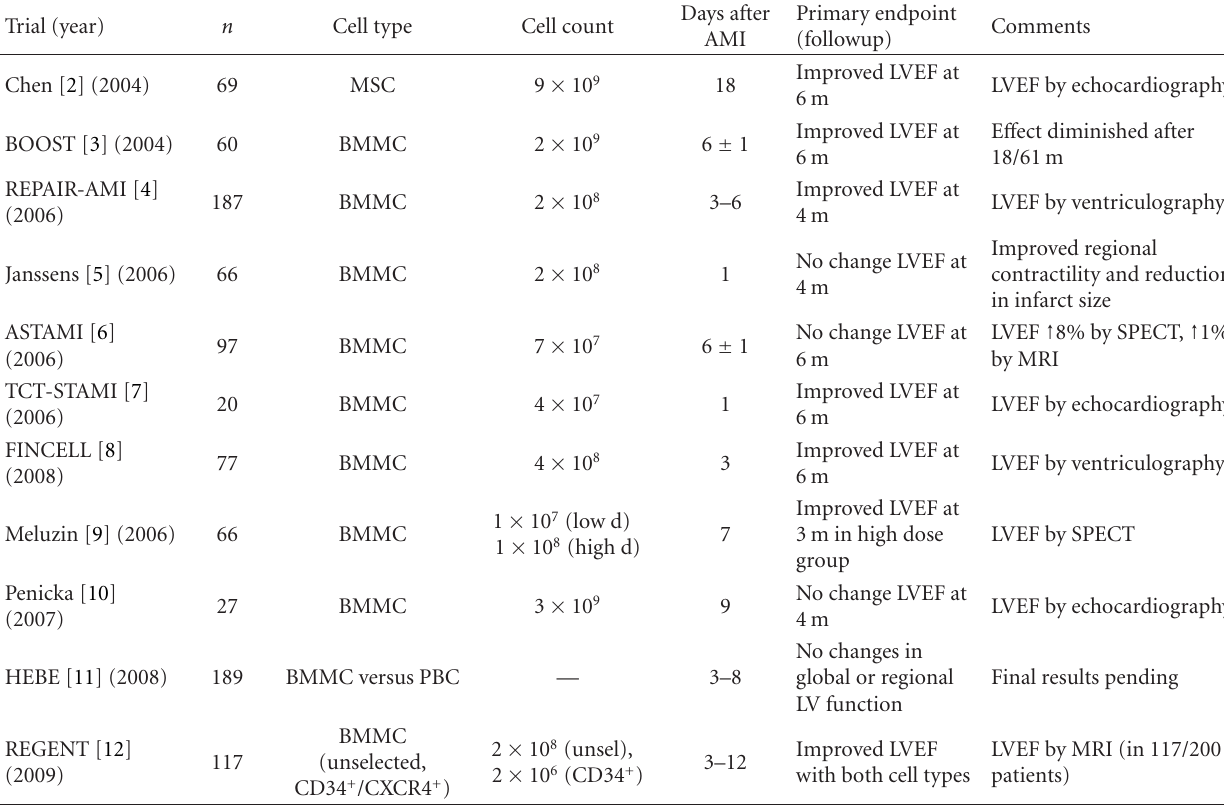
Table 1: Randomized clinical trials with stem cells in patients with acute myocardial infarction (intracoronary delivery). Trial